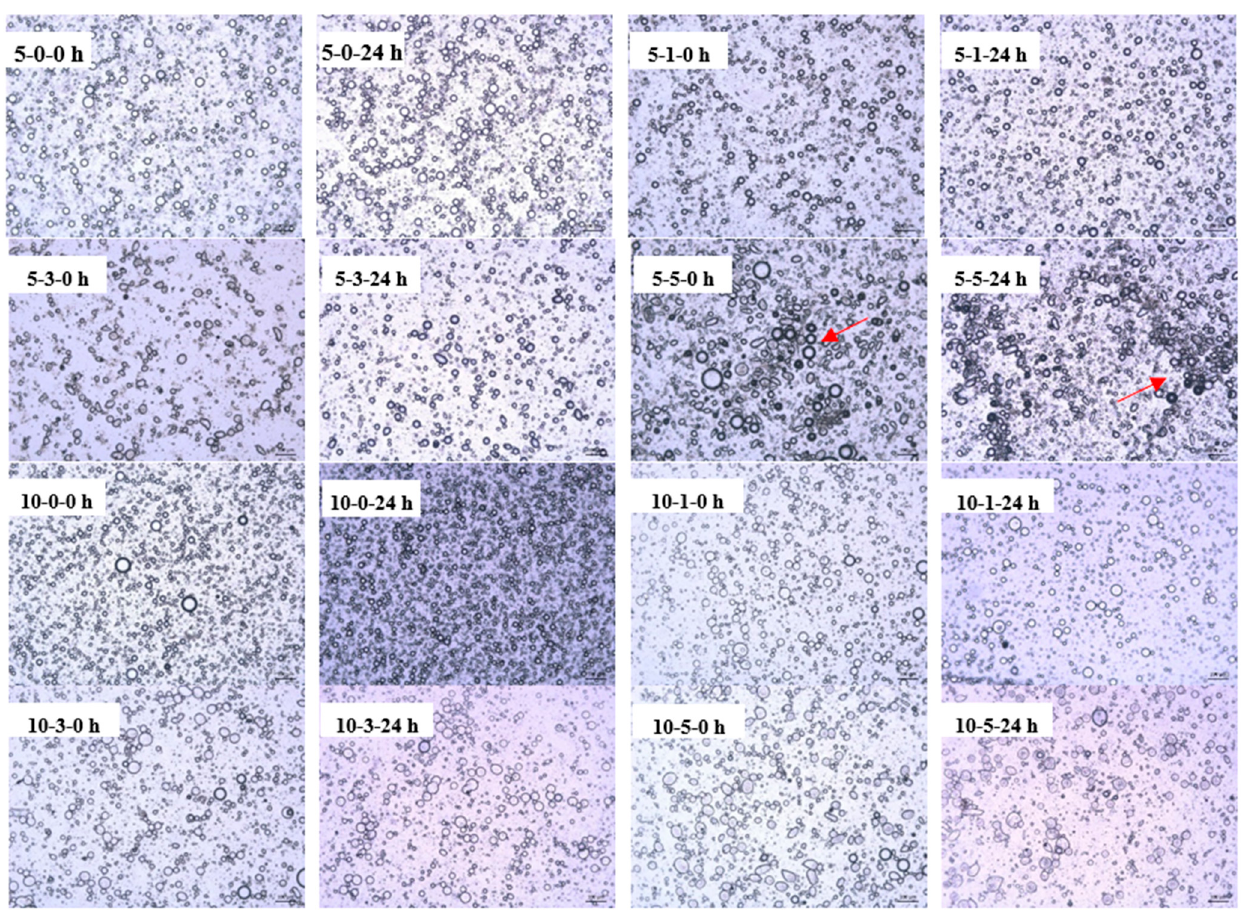
Figure 3. The micrographs of MP O/W emulsion with different concentration of TPP at 0 and 24 h. The droplets appeared to aggregate significantly at high concentrations of TPP (arrow).